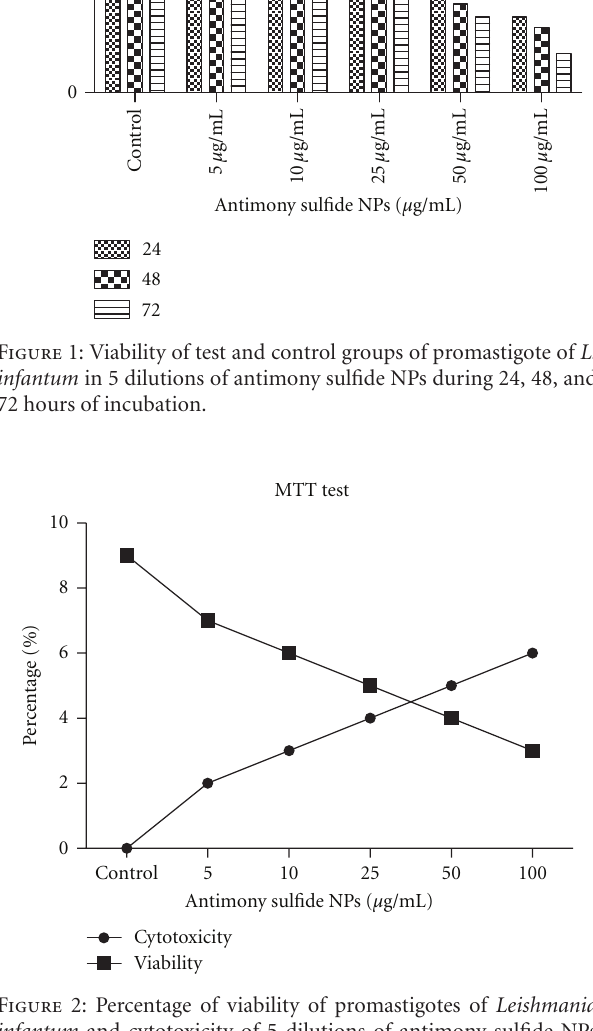
Figure 4: Viability of mouse macrophages contained amastigotes of Leishmania infantum in 5 dilutions of antimony sulfide NPs in vitro conditions during 24, 48, and 72 hours of